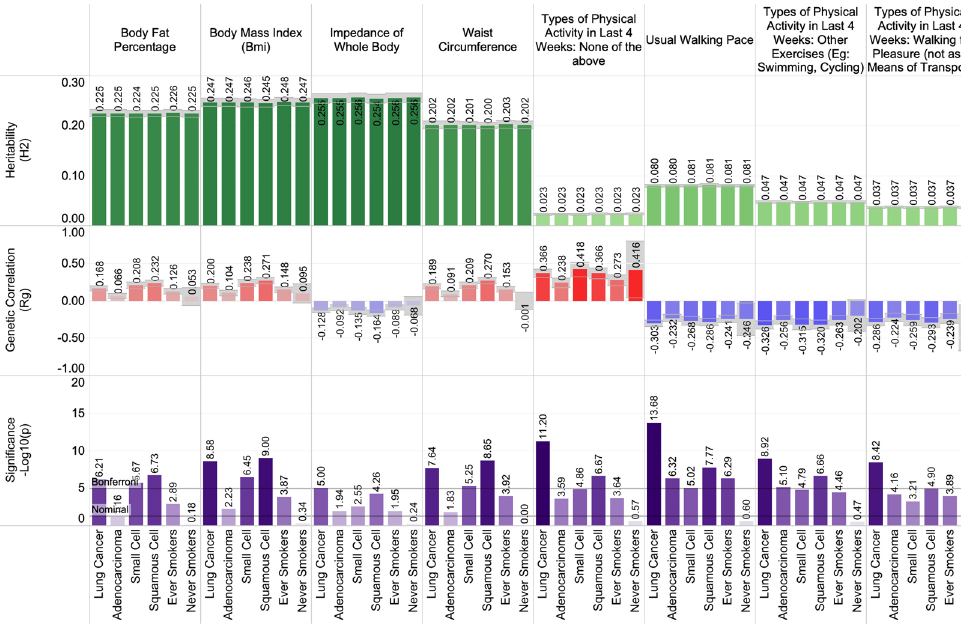
Figure 4. The shared heritability and genetic correlation between fitness with lung